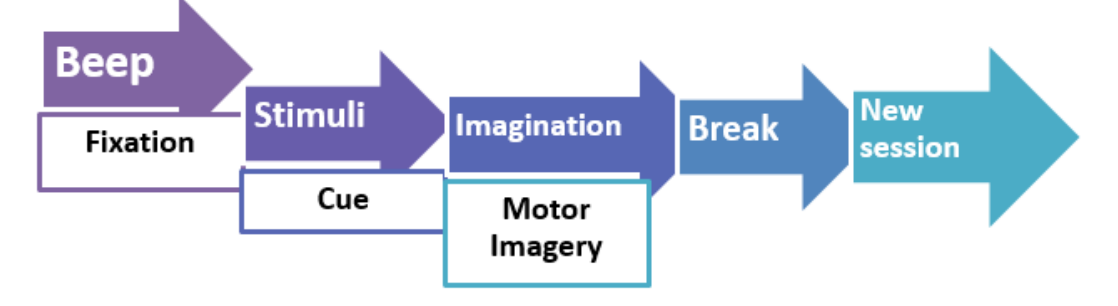
Figure 3. From BCI Competition IV dataset 2a, one trial timing scheme is provided for the MI experimental paradigm based on EEG [41].